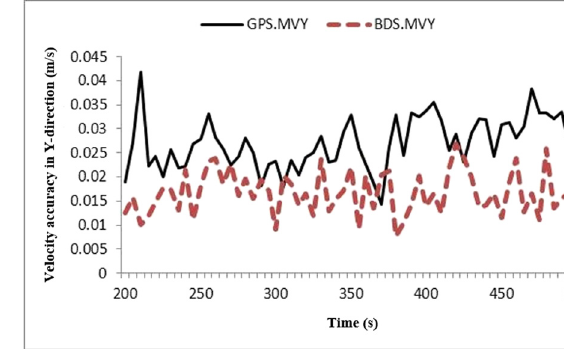
Figure 5: Position precision of on - board BDS and GPS in Y - direction.